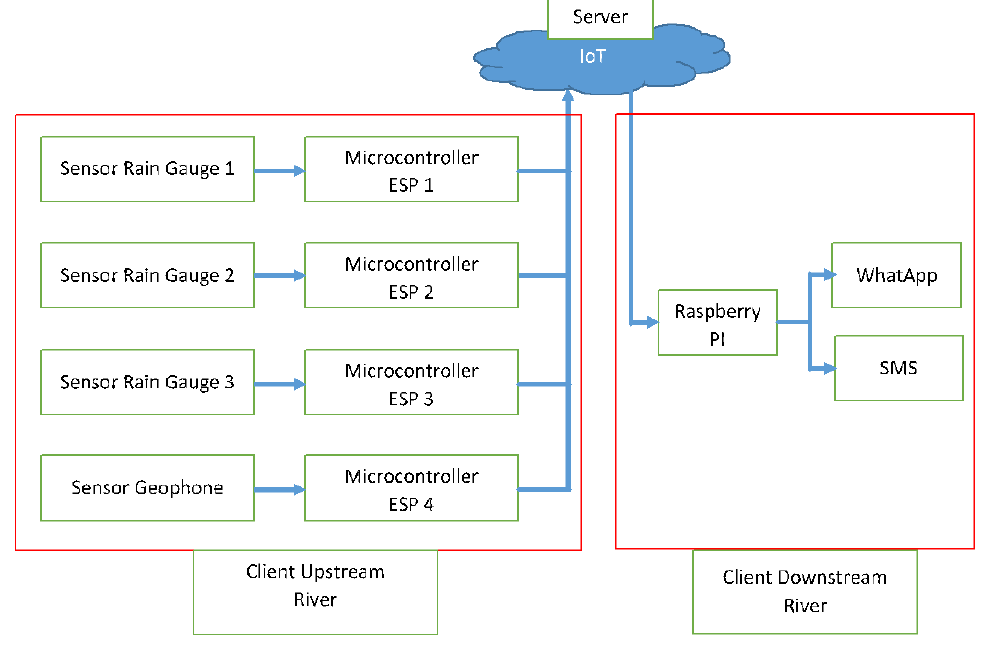
Figure 2. Block diagram of the lava flood detection system.